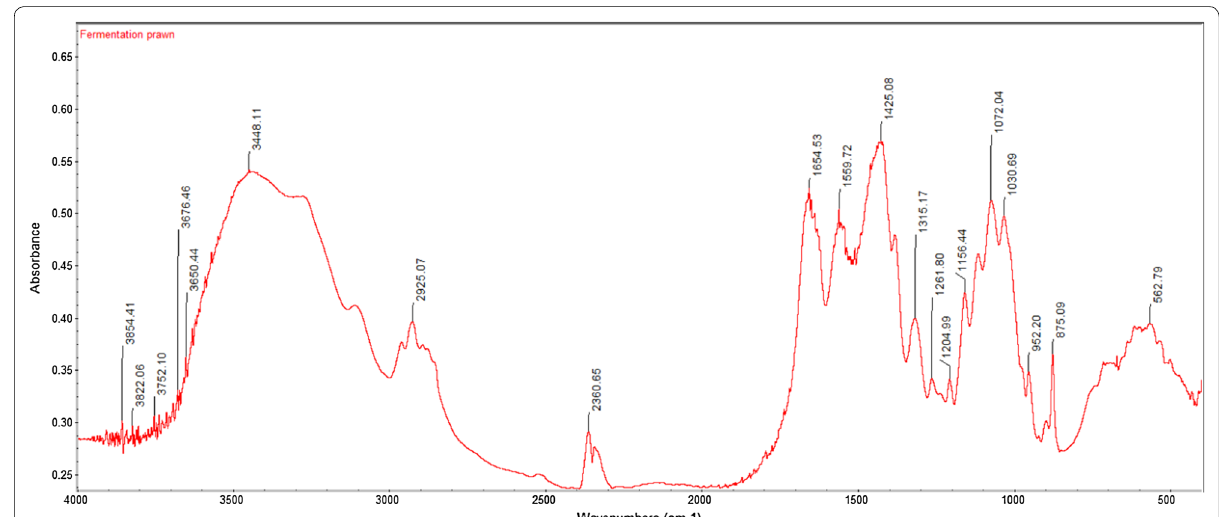
Fig. 2 FTIR spectra of extracted chitin from glucose